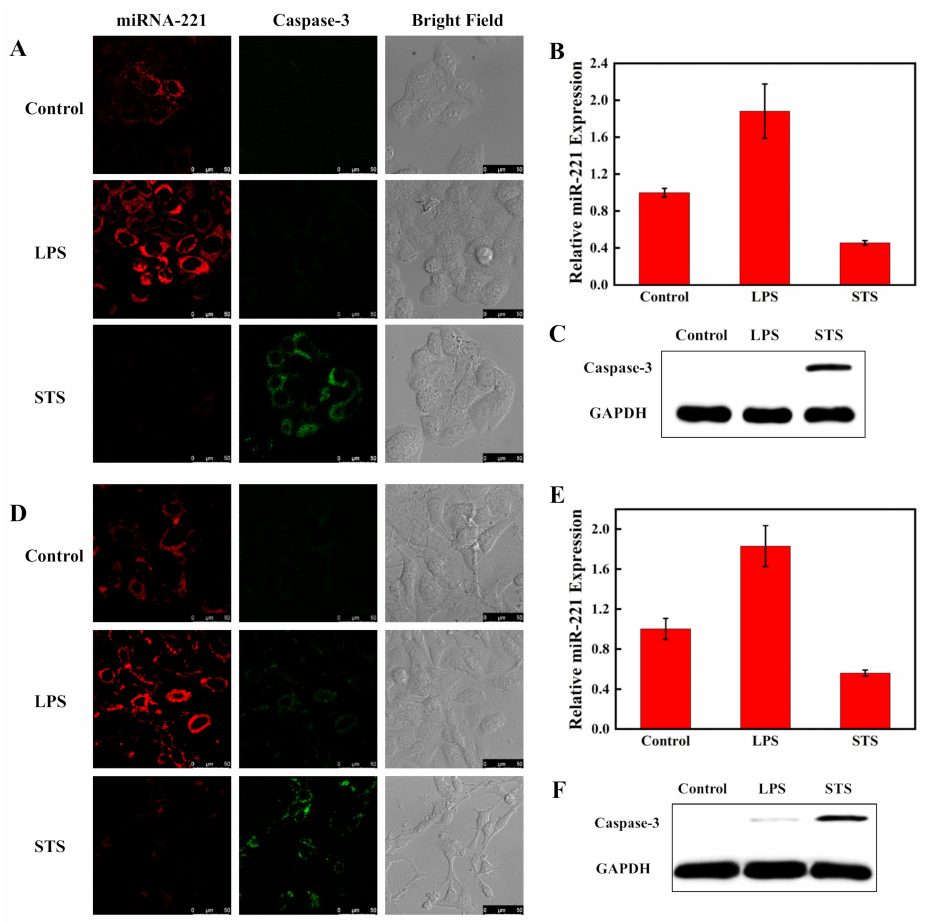
Figure 7. Confocal imaging of miRNA-221 and caspase-3 in Hela ( A ) and A549 cells ( D ). The cells were pretreated with LPS to activate the miRNA-221 level and pretreated with STS to activate the caspase-3 expression. The cells were incubated with the nanosensor for 4 h at 37 ◦ C. The red and green channels were examined with 488 and 633 nm excitation, respectively. Scale bar is 50 µ m. Analysis of miRNA-221 level by RT-PCR in Hela cells ( B ) and A549 cells ( E ) after treatment with LPS and STS. The Western blot assay of caspase-3 expression in Hela cells ( C ) and A549 cells ( F